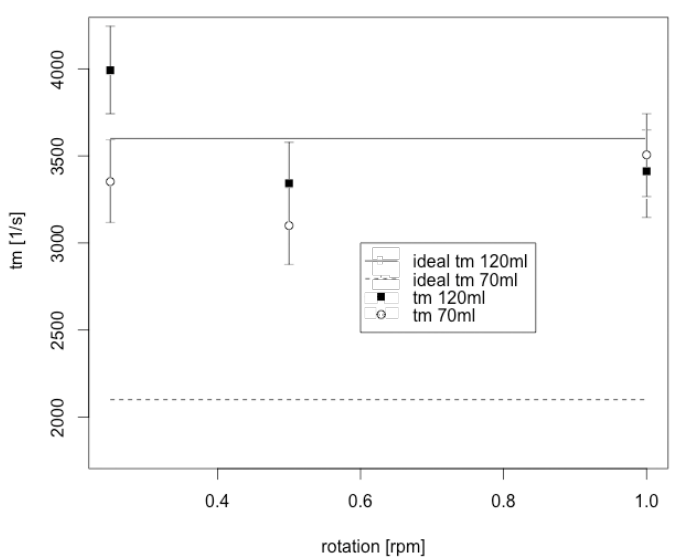
Figure 4. Mean residence time vs. rotation speed of bioreactor bed for different filling volumes (70 mL, 120 mL). Hydrostatic residence time plotted for comparision. Errorbars represent standard